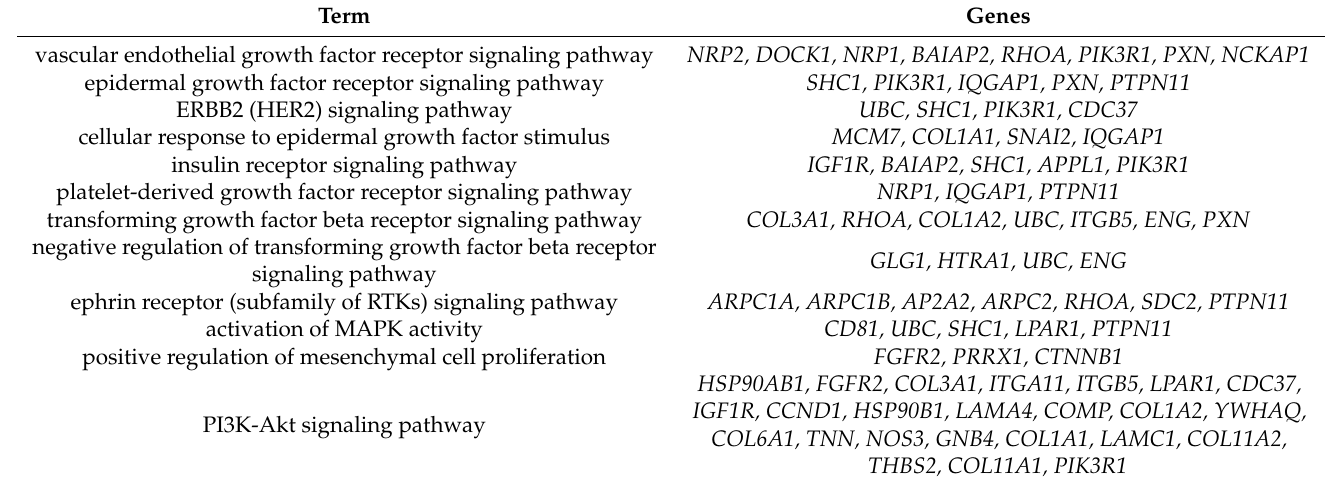
Table 1. The 49 genes in the biological functions and signaling pathways that are related to antler growth rate.